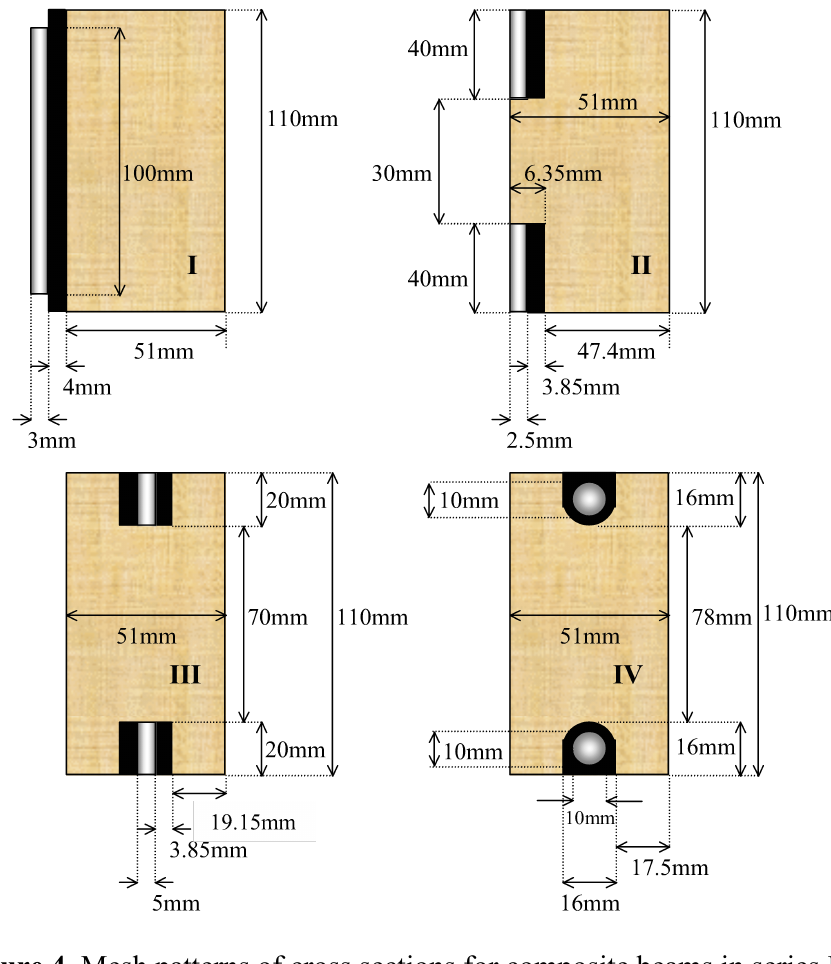
Figure 3. Cross sectional dimensions and layout used in finite element models for beams from series I-IV (labelled). In each series, the laminated veneer lumber (LVL) is textured brown, the adhesive is black and the steel reinforcements are shaded grey.